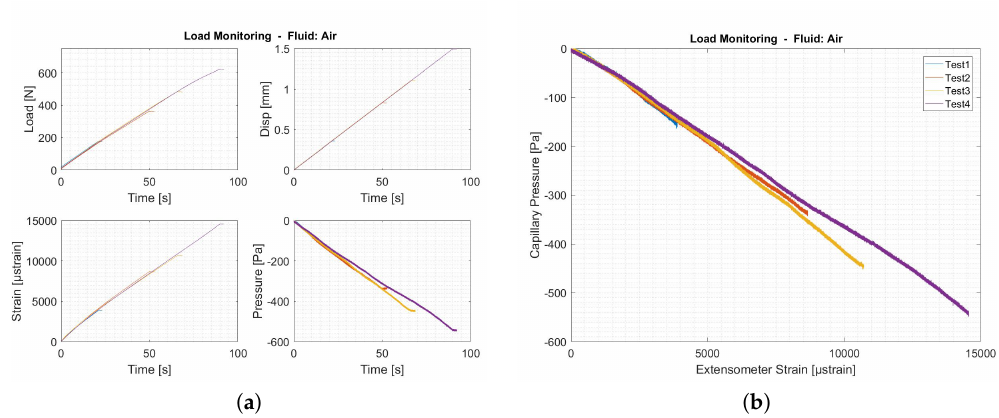
Figure A1. Tensile testing results: Load monitoring system with capillary filled with air is compared to extensometer strain measurements. ( a ) Raw data ( b ) Capillary pressure of the load monitoring system compared to the extensometer measurements.